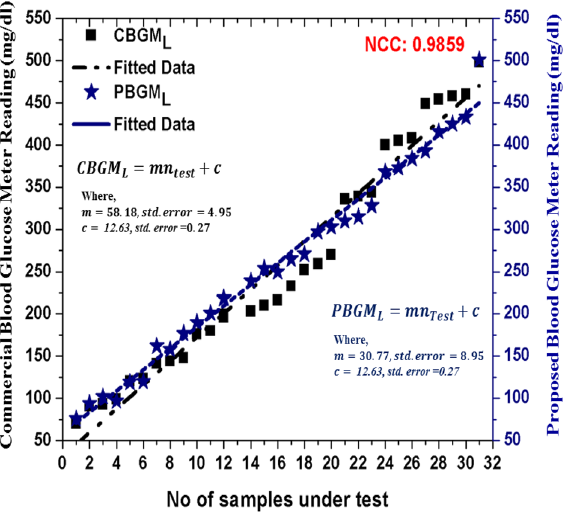
Figure 5. Corroboration between commercial and proposed blood glucose meter level.